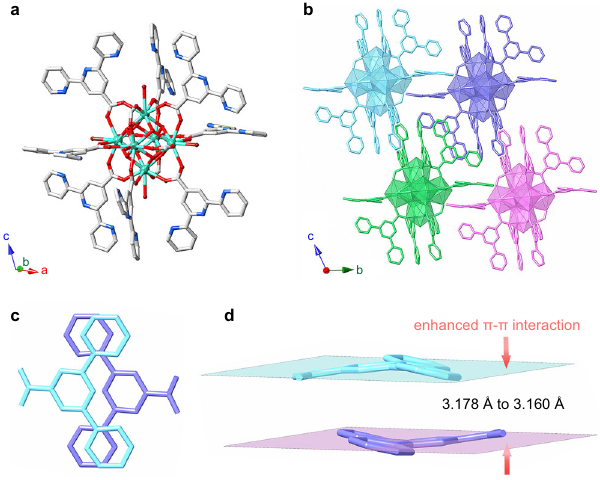
Fig. 1 Crystal structure of Th-SINAP-100. a Molecular structure of Th- SINAP-100. Color code: Th green, O red, N blue, and C gray. H atoms are omitted for clarity. b Topological representation of the packing of 0D clusters. c Top view showing the π – π interactions in the structure of Th- SINAP-100. d Side view showing the π – π interactions in the structure of Th-